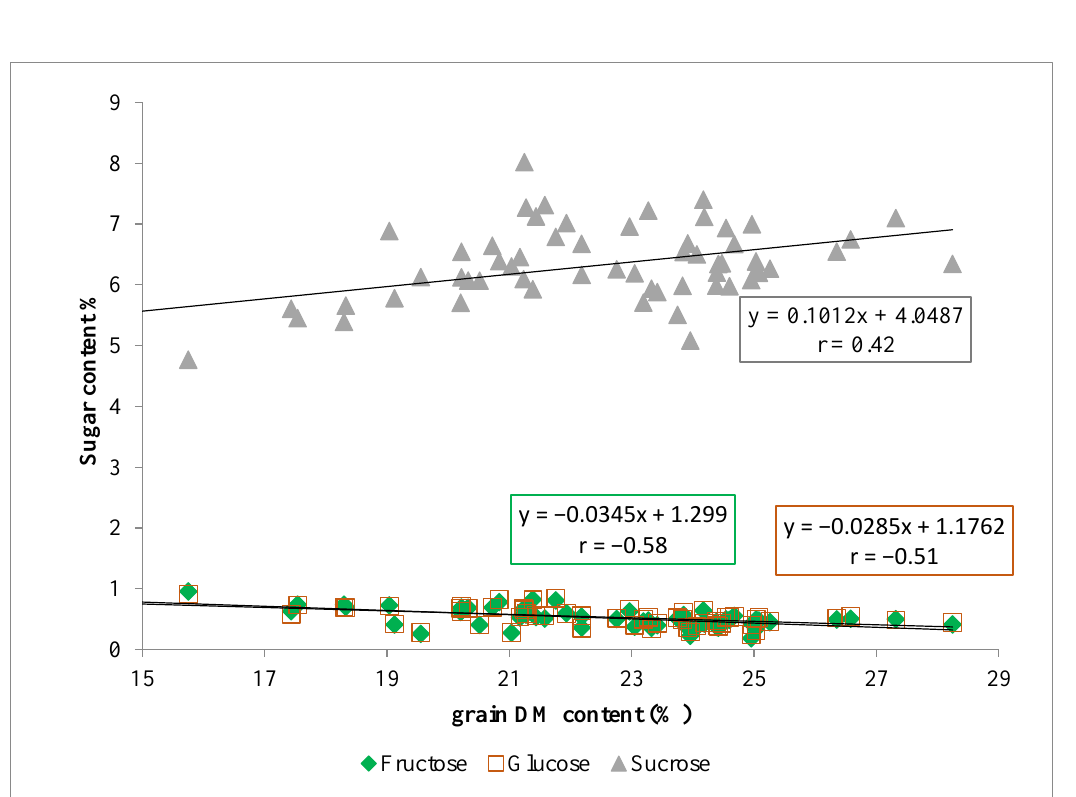
Figure 3. Regression curve between grain dry matter (DM) content and sugar content (% of fresh matter).